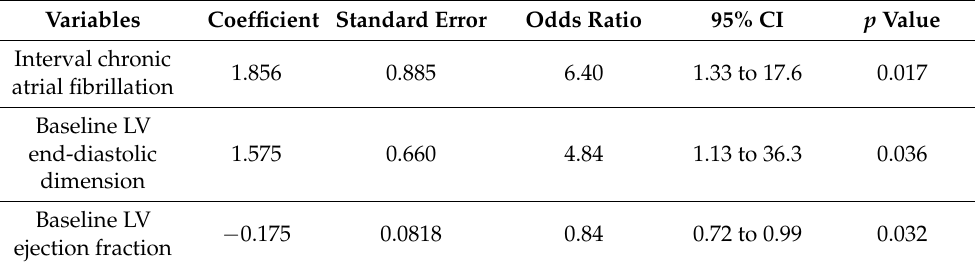
Table 5. Independent predictors of internal HFrEF in asymptomatic patients with hypertensive concentric